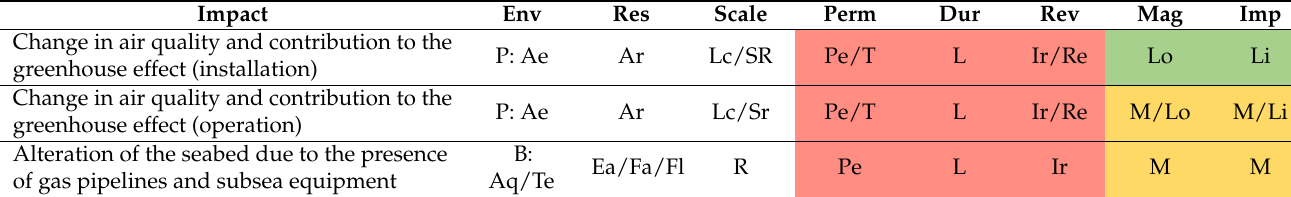
Table 6 lists the relevant environmental impacts caused during Stage 2. The key is as follows: Environment (Env): Biotic (B) or Physical (P), Aquatic (Aq), Terrestrial (Te), Aerial (Ae); Resource (Res): Fauna (Fa), Flora (Fl), Air (Ar), Earth (Ea); Water (W); Scale: Local (Lc), Regional (R), Superregional (SR); Permanence (Perm): Temporary (T), Permanent (Pe); Duration (Dur): S, M, L; Reversibility (Rev): Re, PR, Ir; Magnitude (Mag): Lo, M, H; Importance (Imp): Li, M, G. Created based on